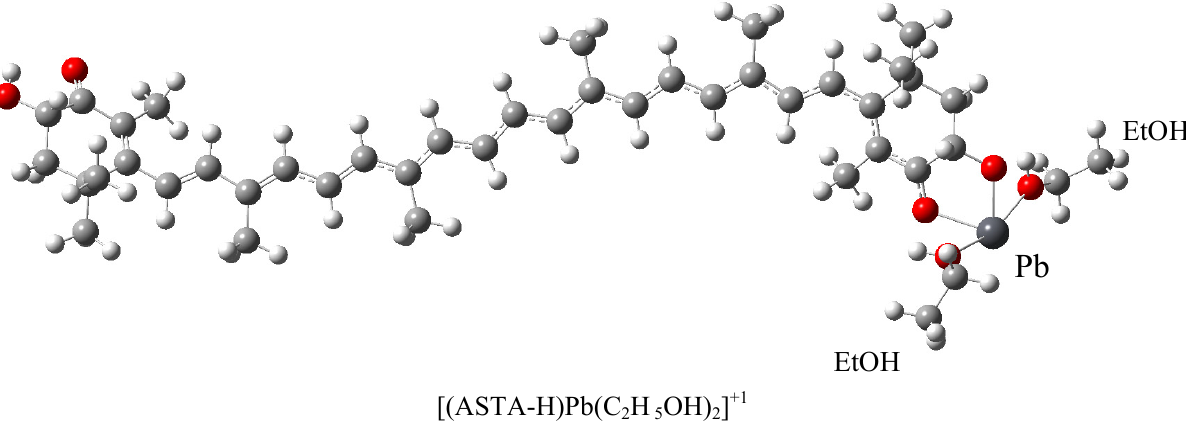
(C H OH) ] +2 2 2 5 4